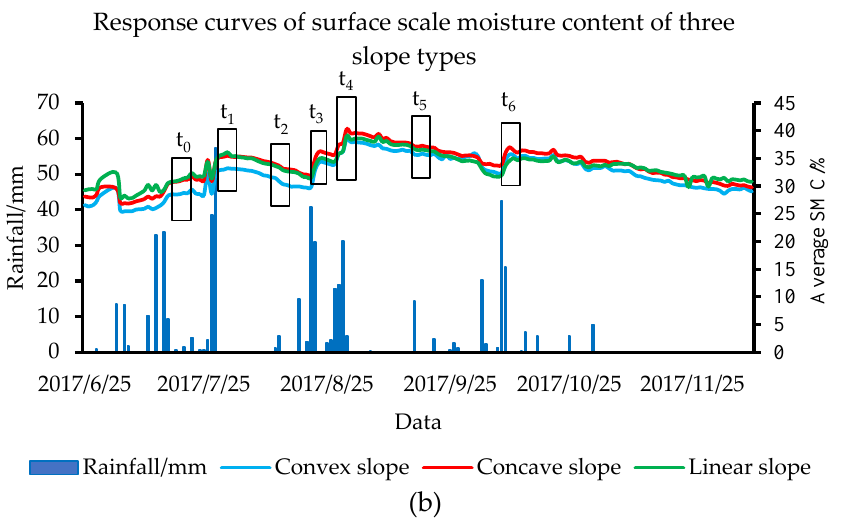
Figure 10. The time sequence diagrams of changing with time under two conditions were as follows: ( a ) concave slope, convex slope and linear slope at 33 ◦ position (within 4 m from the ground); ( b ) concave slope, convex slope and linear slope (within 4 m from the ground).